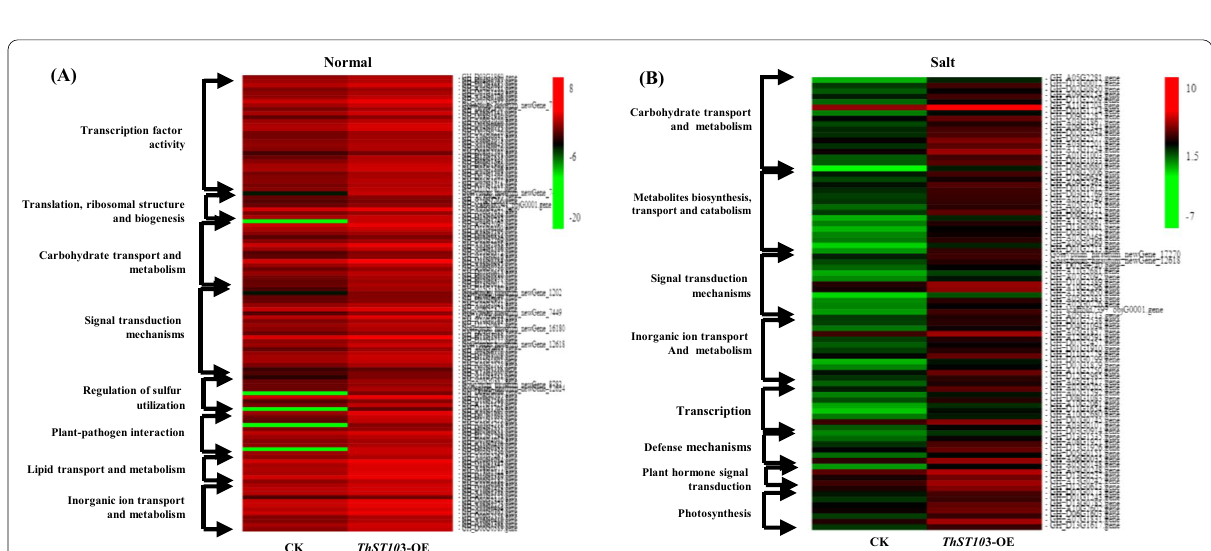
Fig. 7 Heat maps of DEGs in normal and saline conditions. A Heat map of common differentially expressed genes in CK and ThST103 -OE under normal condition. B Heat map of common differentially expressed genes in CK and ThST103 -OE under salt stress. Red and green colors indicate up- and down- regulated genes, respectively, from both control and salt treated plants. The results were presented as log2 ratios. Only results with a P value < 0.05 and that have been confirmed in three independent experiments were